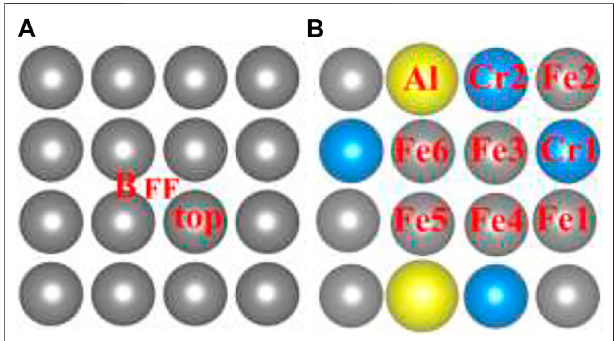
FIGURE2| Theinitialsitesofthehydrogenatomandmolecule(H/H 2 )on the Fe and FeCrAl (100) surface.